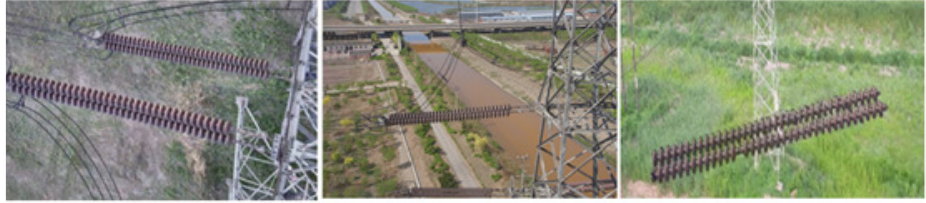
Figure 2. Aerial images of insulators on different backgrounds.